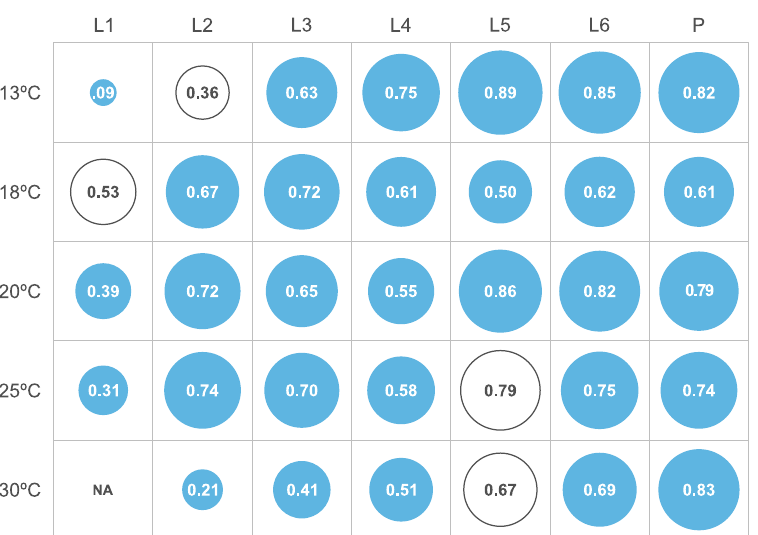
Figure 3. Best overlap scores between predicted and observed phenology distributions of C. incommoda life stages at five temperatures. White circles indicate situations where Model 2A outperformed Model 2B, blue circles the opposite situation. Overlap score varies between 0 (no overlap) and 1 (complete overlap) and is proportional to the circles radius. L1-L6 = larval instars. P = pupa. NA = situation where the evaluation data consisted of a unique mean value, impeding the computation of an overlap score.